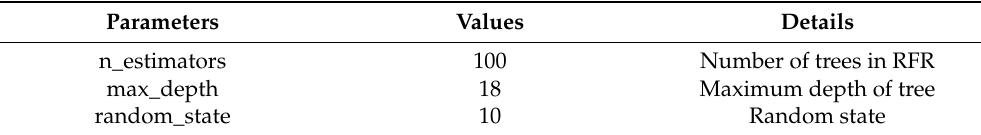
Table 4. Optimized RFR hyperparameters.